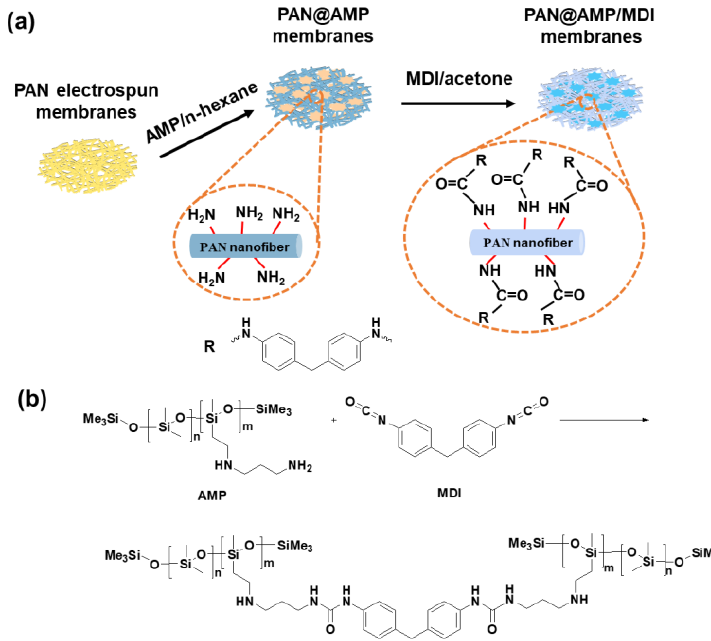
Figure 1. ( a ) Schematic illustration of the preparation procedure of fluoride-free PAN@AMP/MDI nanofibrous membranes. ( b ) The cross-linking reaction between AMP and MDI.